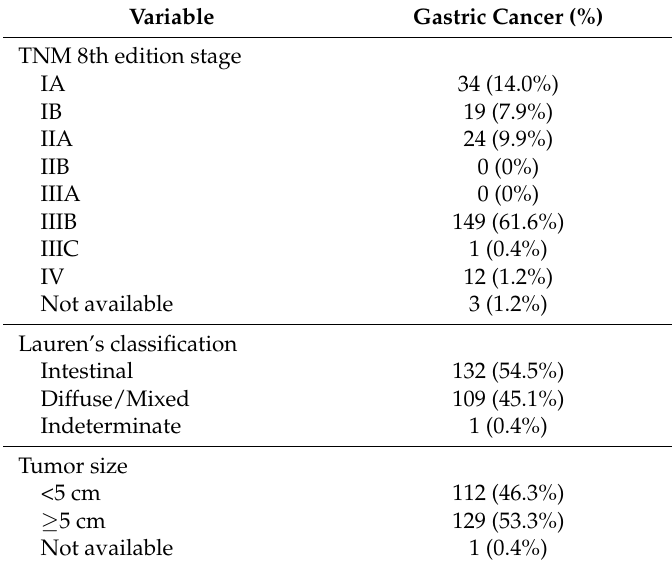
Table 1. Clinicopathological characteristics of gastric cancer